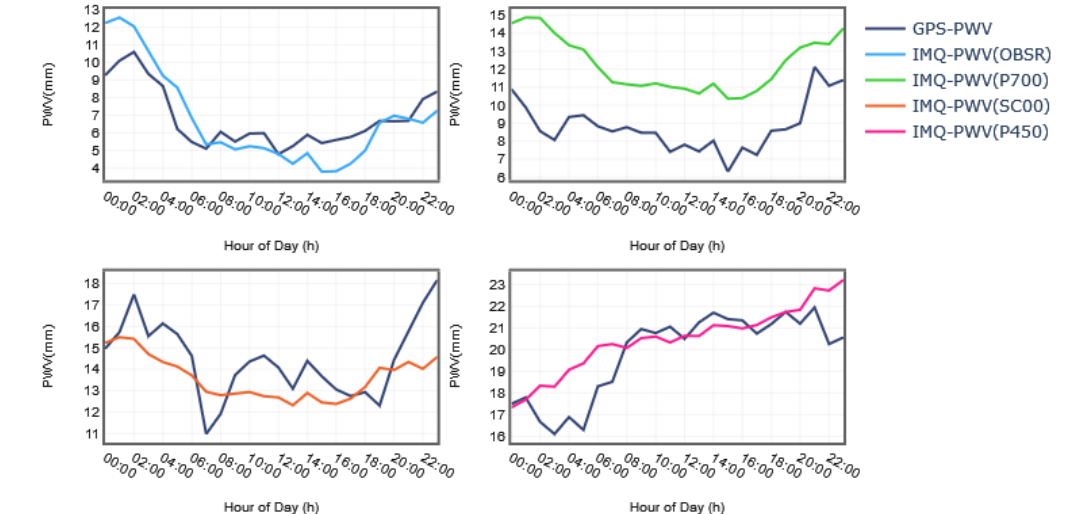
Figure 6. Comparison between PWV obtained from GPS signals and PWV obtained from IMQ interpolation of the four control stations